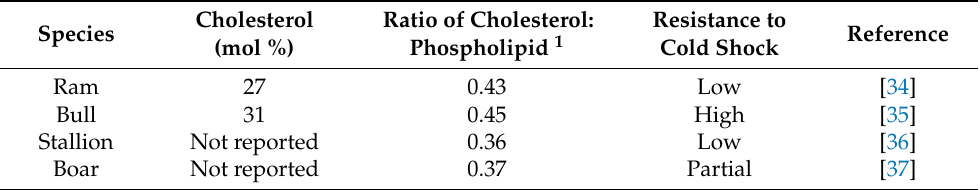
Table 2. Summary of publications investigating semen storage temperatures between 20 and 37 °C in various species.